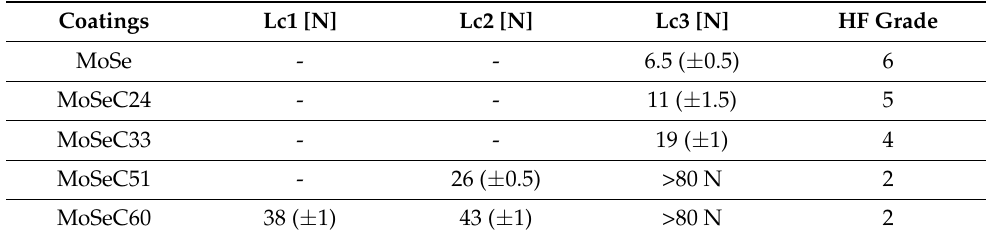
Table 3. Average critical load at which each failure event occurred during scratch test on the 5 distinct carbon content samples and HF grade attributed to each coating based on Rockwell C